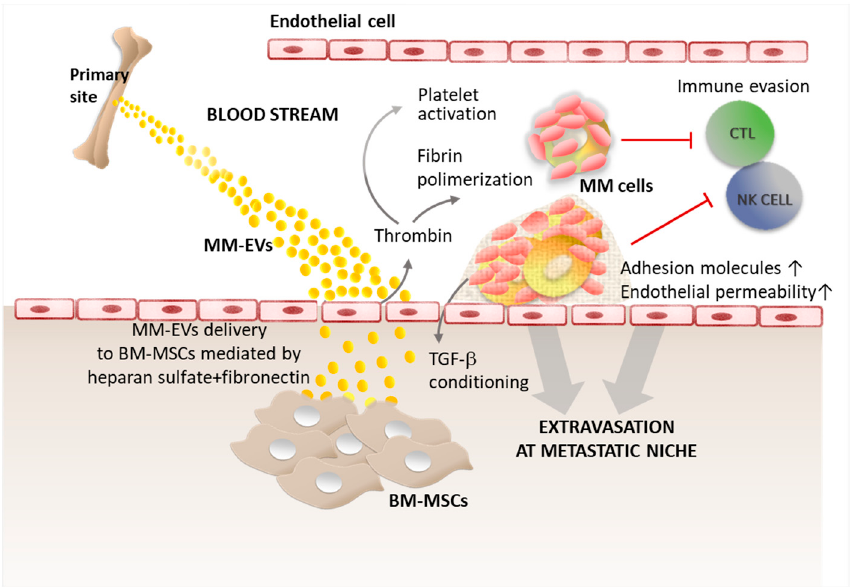
Figure1. EVssupportmyelomacelljourneyinthebloodstreamandcanbedeliveredatthepremetastatic Figure 1. EVs support myeloma cell journey in the blood stream and can be delivered at the niche. See the text for premetastatic niche. See the text for details.